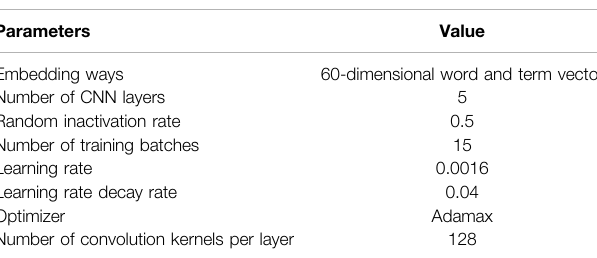
TABLE 1 | Parameter settings.